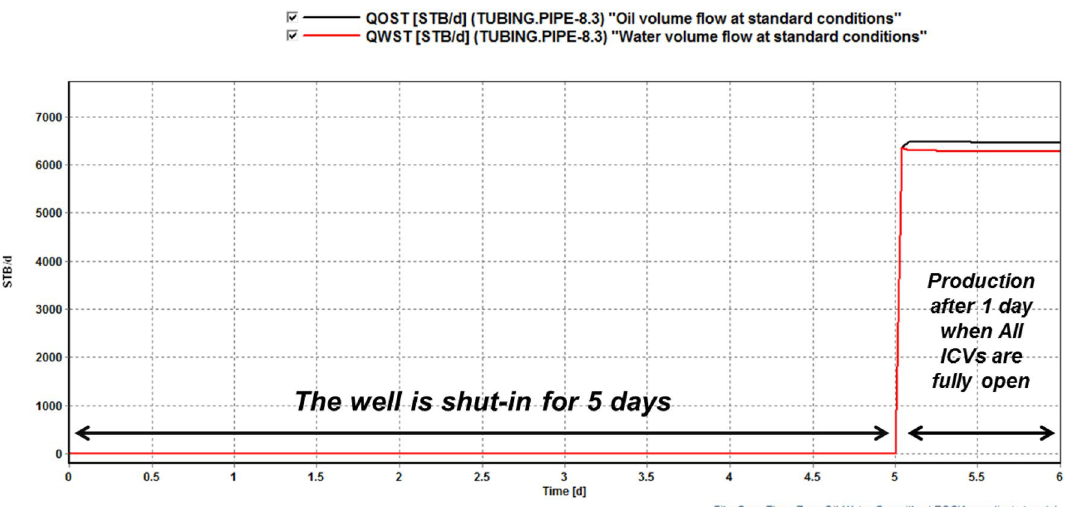
Fig. 7 Total oil and water production from the five-zone I-well